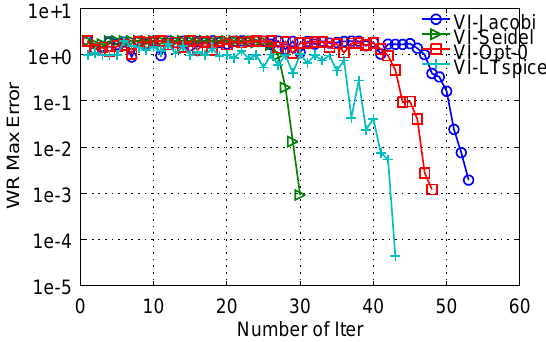
Figure 11: The WR error as function of the number of iter- ations: case of the low resistive load, a time window of 24 times the switching period of the